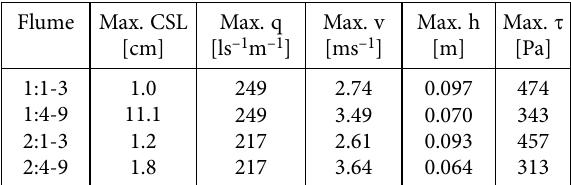
Table 6. Max. cumulative soil loss (CSL) and hydraulic forces, short-term tests series with focus on the upper (“1 – 3”) and lower (“4 – 9”) test sections, vegetated, September 2014